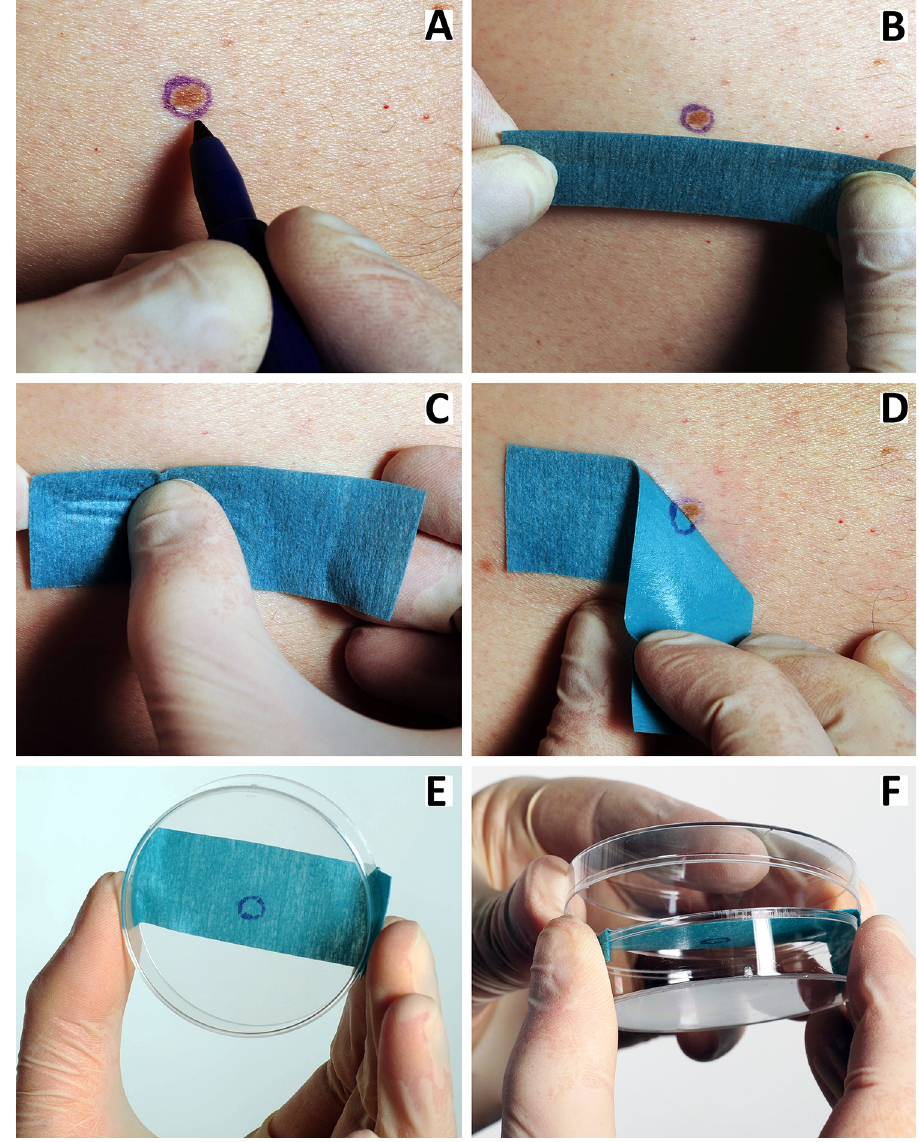
Fig 2. Tape stripping. A sequence of pictures illustrating the tape stripping procedure. First, a line is drawn around the lesion with a pen ( A ). After approximately 15 seconds, a tape strip is placed on the lesion, and the investigator massages the tape gently against the lesion for 20 seconds using the thumb ( B, C ). The tape strip is then removed from the skin ( D ) and transferred to the rim of a Petri dish with the harvested RNA facing down, not touching the sides of the dish ( E ). The lid is mounted to fix the tape and protect against contamination ( F ). The sample is handled with gloves to avoid contamination with RNA from the